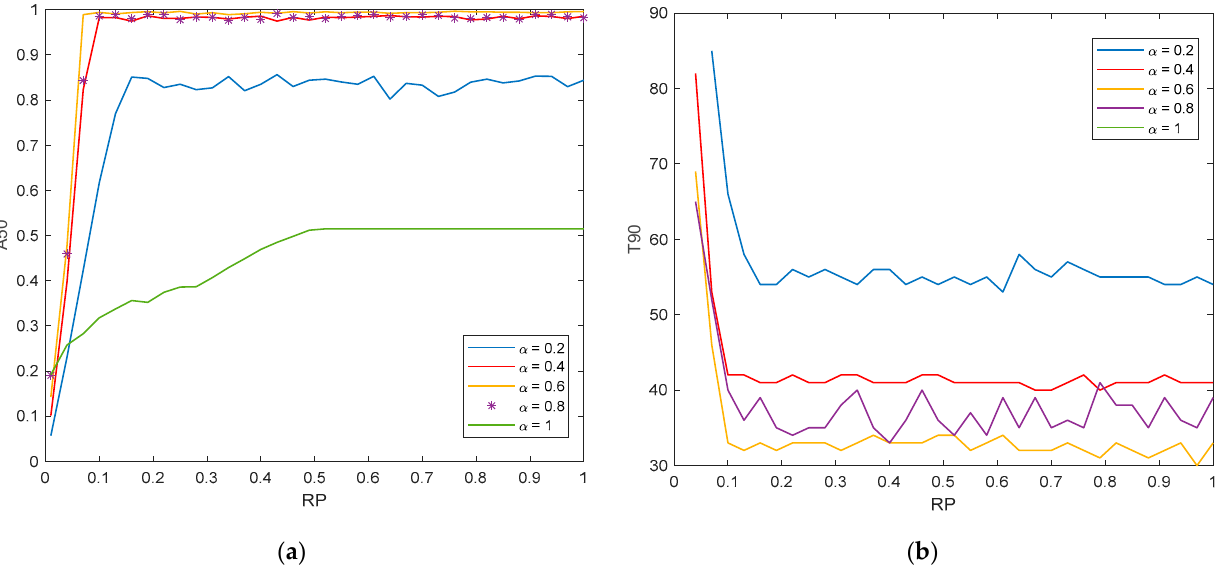
Figure 10. The results of ( a ) recovery levels at time step 50, P = 0.1, ( b ) 90% recovery time, P = 0.1, under load-based cascading failures with different certainty levels and various recovery potentials in the Minnesota road network.